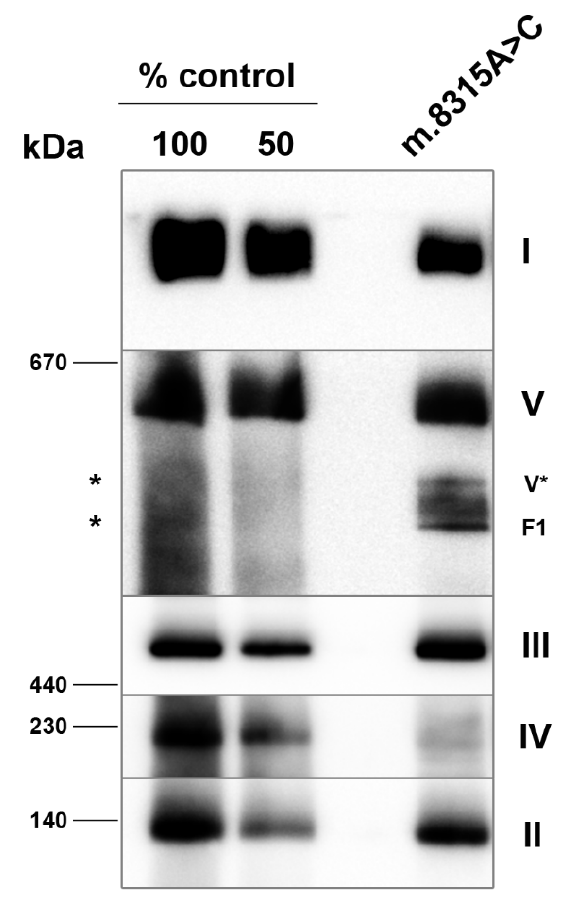
Figure 2. Analysis of the assembly of OXPHOS complexes by immunoblotting of BN-PAGE in muscle mitochondria. BN-PAGE of lauryl maltoside-solubilized mitochondria was electroblotted onto PVDF membranes and probed with monoclonal antibodies that detect the native forms of the OXPHOS complexes. Two aliquots of control mitochondria corresponding to the indicated dilutions of control samples were loaded on the same gels. I—complex I; II—complex II; III—complex III; IV—complex IV; V—complex V; V*—complex V subcomplex composed of F1-ATPase with several c-subunits; F1—F1-ATPase; *-expected migration of complex V